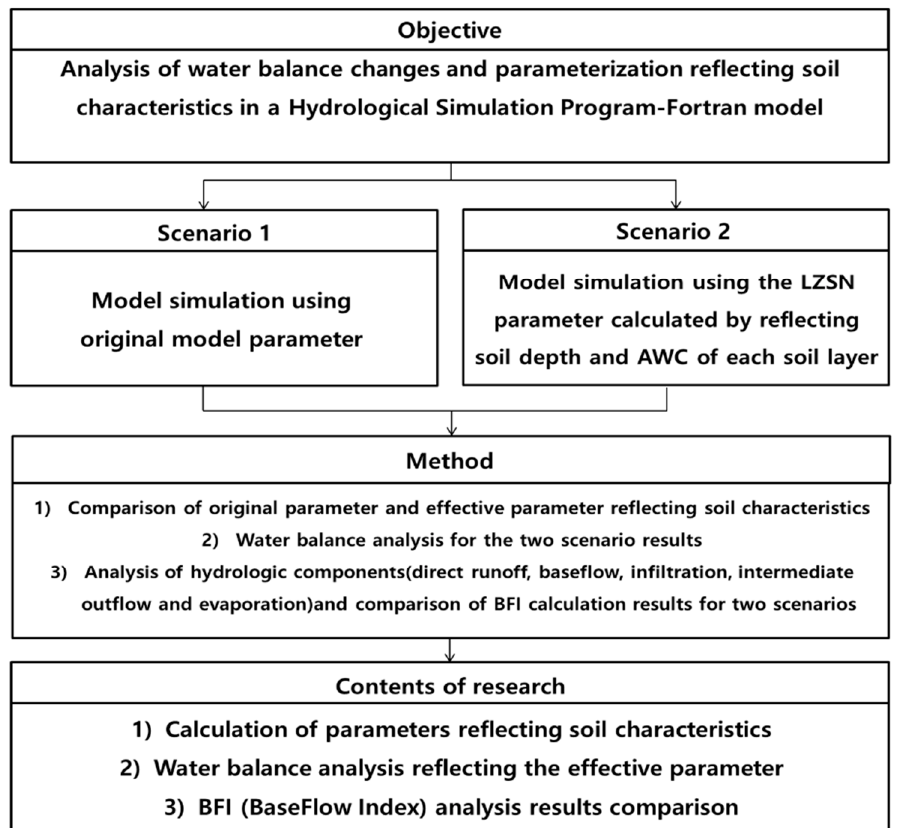
Figure 5. Flowchart of the study design.